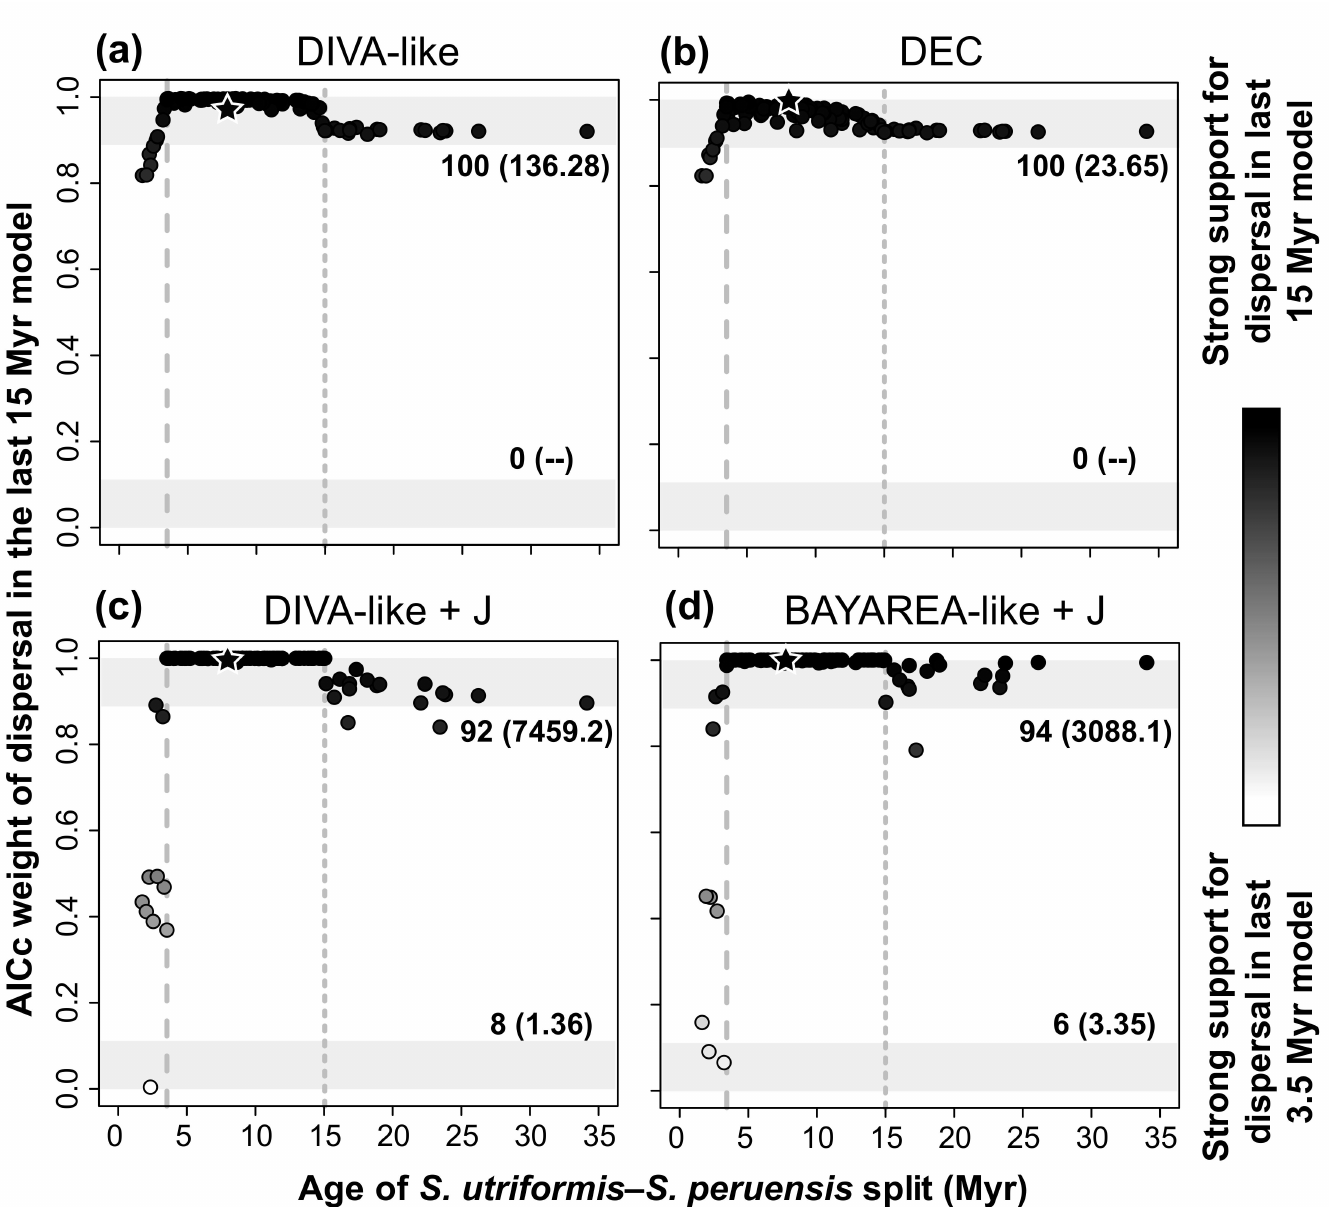
Figure 6. Relationship between AIC weight of the time-stratified biogeographic model allowing dispersal only during the last 15 Myr (relative to the time-stratified model allowing dispersal only during the last 3.5 Myr) and the age of split of Sicarius utriformis (from Galapagos) and its sister species. Each dot represents an individual tree of a sample of 100 taken from the posterior distribution of a Bayesian analysis; the star represents the maximum clade credibility tree. Values of AIC weight close to 1 (darker shades) indicate strong support for the 15 Myr model, while values close to 0 (lighter shades) indicate strong support for the 3.5 Myr model The light grey areas at the top and bottom of the graphs are the zones where the support for one of the alternative models is decisive. The dashed vertical lines indicate the boundary between time slices in each of the time-stratified models. Numbers at the top and bottom of the graph are the number of trees supporting each model, and the median support relative to the alternative model. With few exceptions, most trees fit decisively better to a model allowing for dispersal in the last 15 Myr, regardless of the age of the